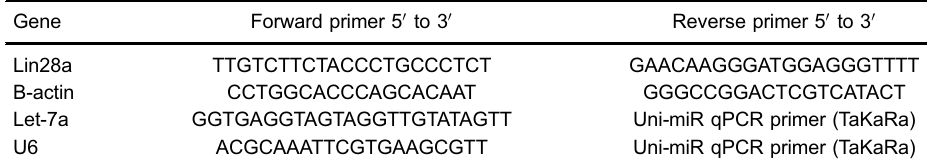
Table 1. Primers used in real-time